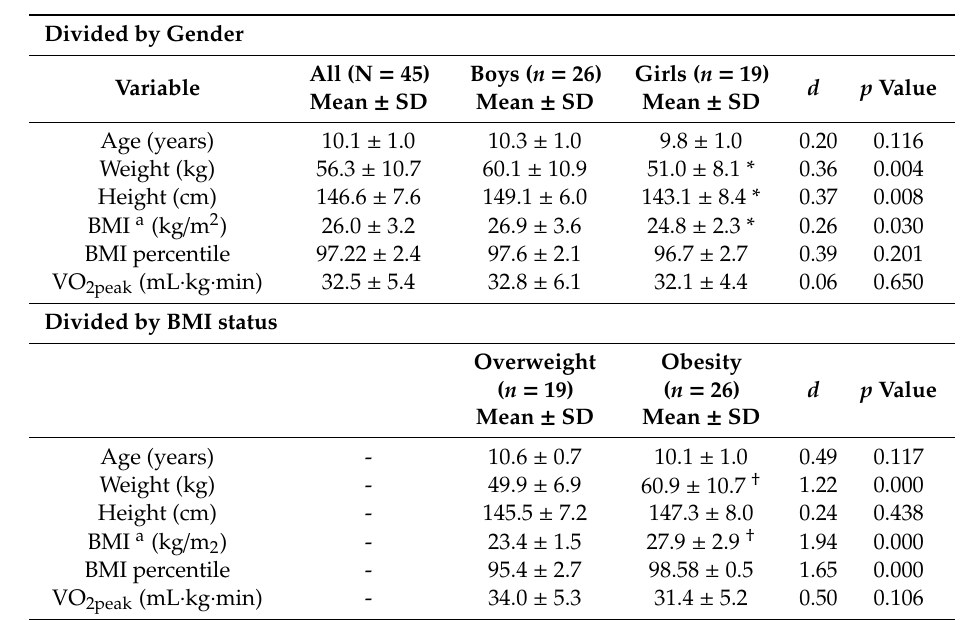
Table 1. Participant characteristics.